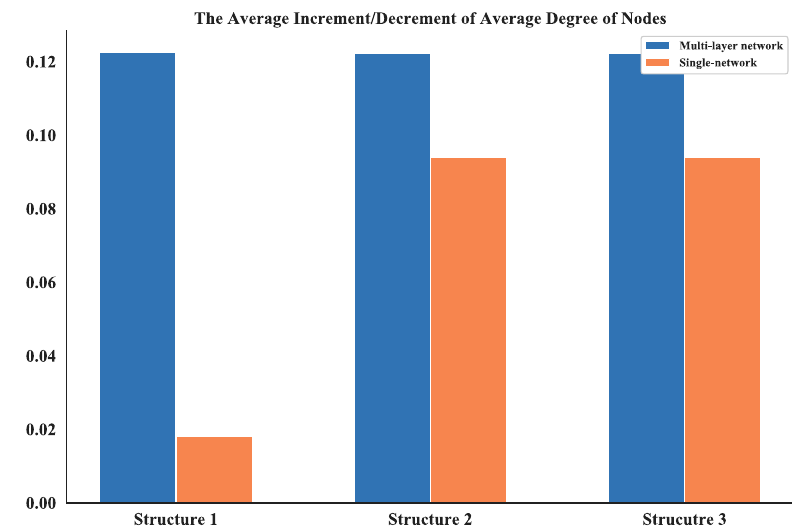
Figure 23. The average increment/decrement of average degree of nodes.